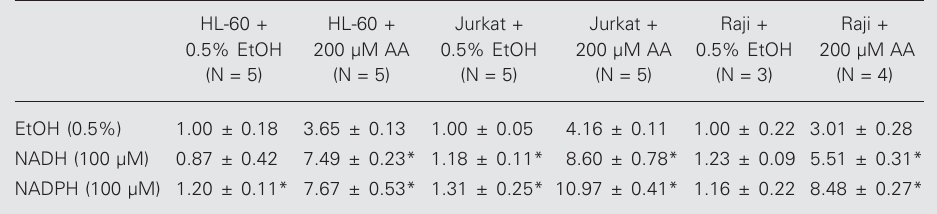
Table 2. Nitroblue tetrazolium reduction by cells treated with NADPH or NADH.